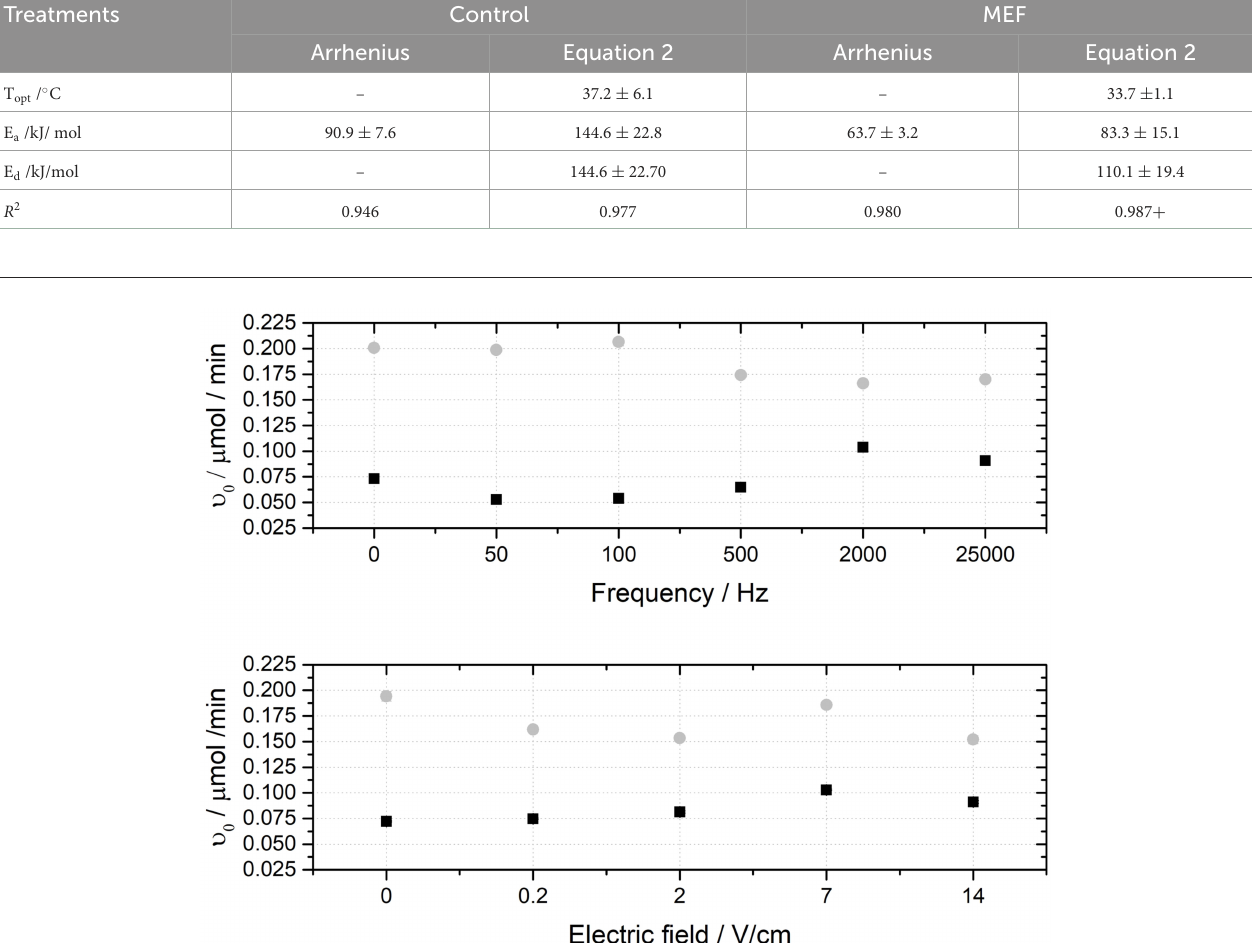
TABLE 2 Model predictions for control and MEF assays.